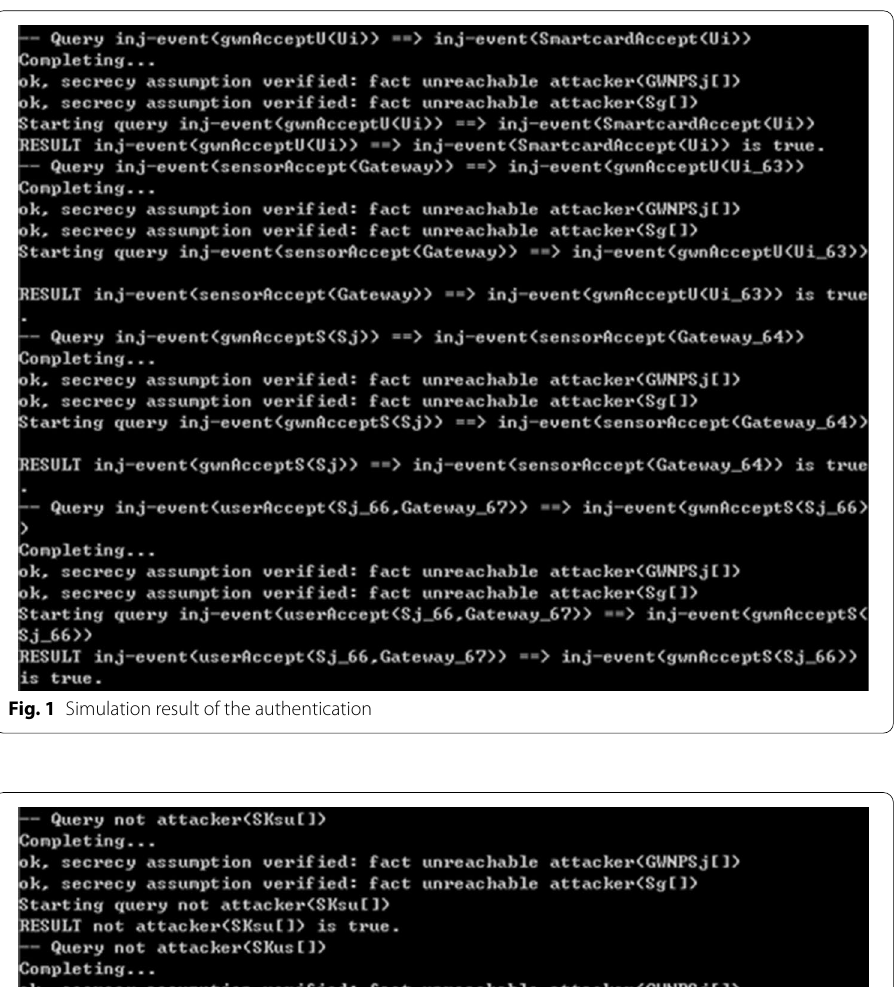
Fig. 2 Simulation result of the session